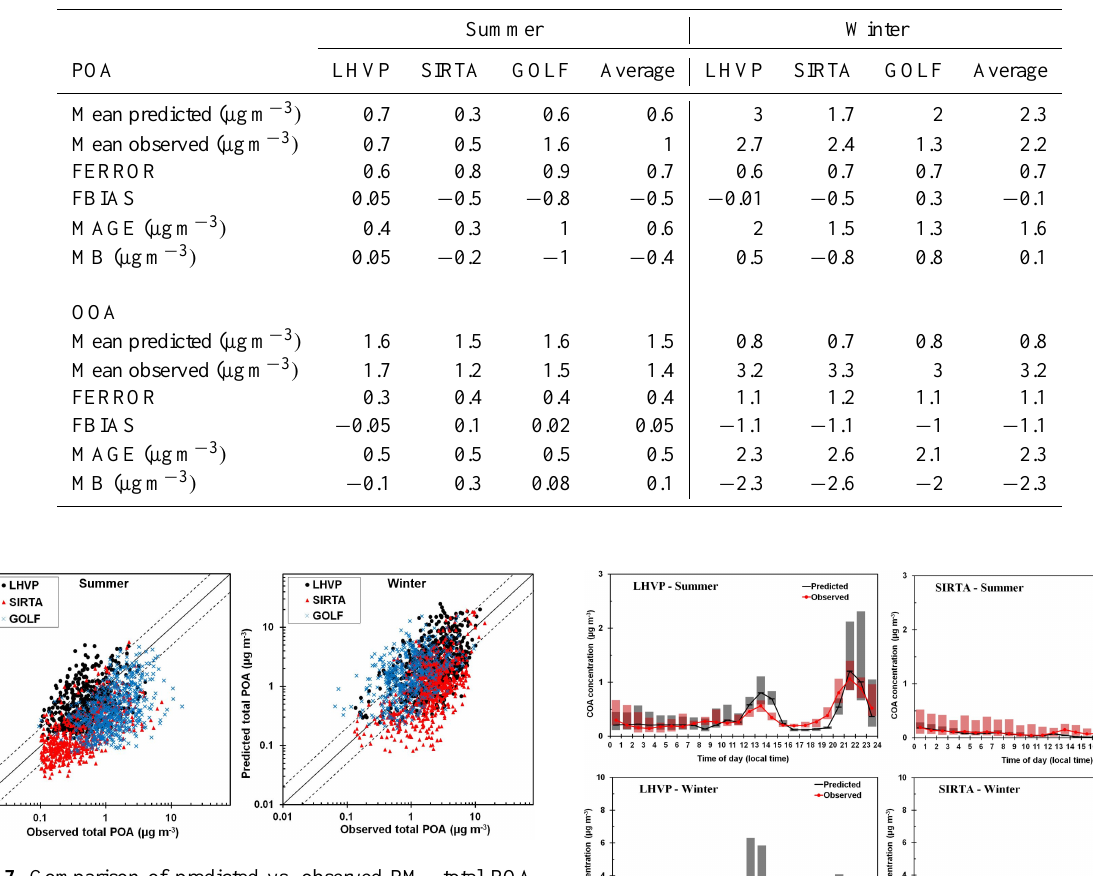
Table 4. Prediction skill metrics of PMCAMx with the addition of COA against observed hourly data.